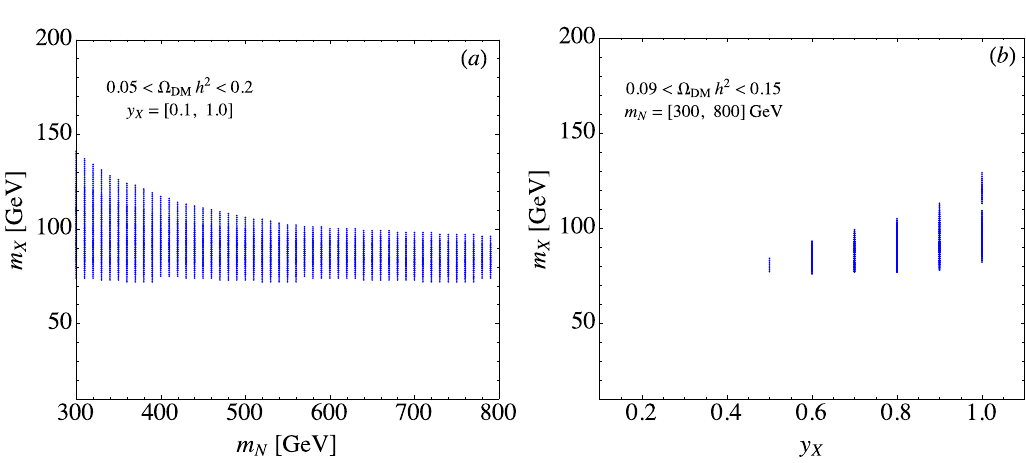
Table 2 . The h ‘ Yukawa matrix element values (in units of 10 (cid:0) 3 eV = 2 v (cid:1) ), where the central values ij obtained by a global (cid:12)t analysis in [80] are applied.